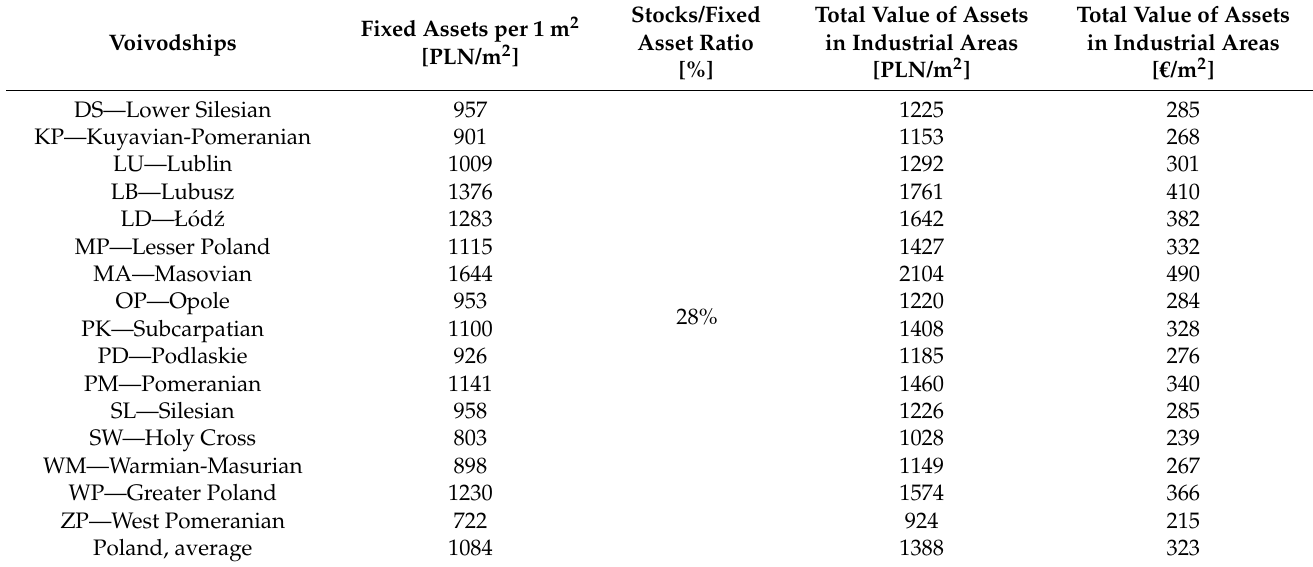
Table 9. Value of fixed assets in industrial areas in 16 voivodships (in 2019 prices).